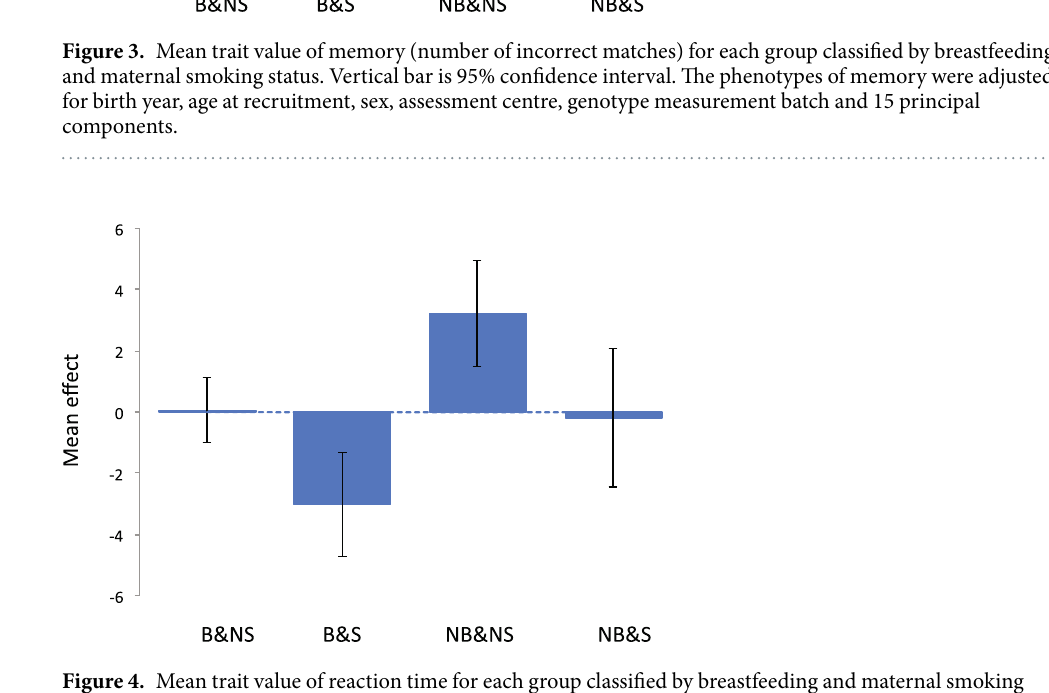
Figure 4. Mean trait value of reaction time for each group classified by breastfeeding and maternal smoking status. Vertical bar is 95% confidence interval. The phenotypes of reaction time were adjusted for birth year, age at recruitment, sex, assessment centre, genotype measurement batch and 15 principal